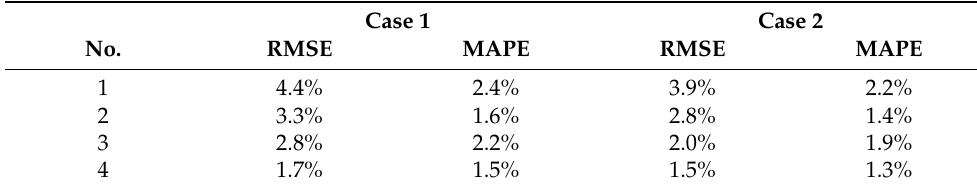
Table 7. Errors of capacity estimation